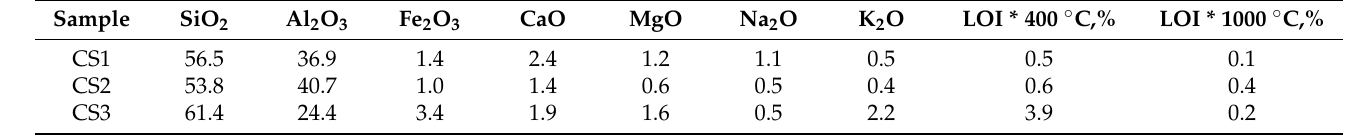
Table 4. Chemical composition of cenospheres in